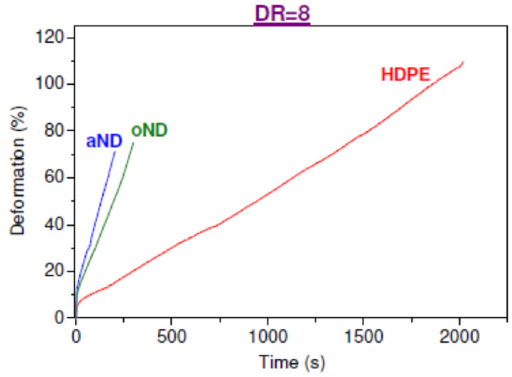
Figure 8. Examples of the creep curves for the HDPE-based oriented composite fibers filled with 5 wt.% nanodiscs.